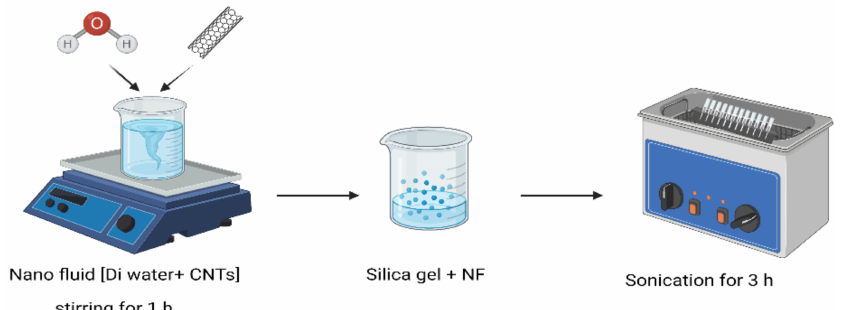
Figure 1. Preparation procedure for silica gel with